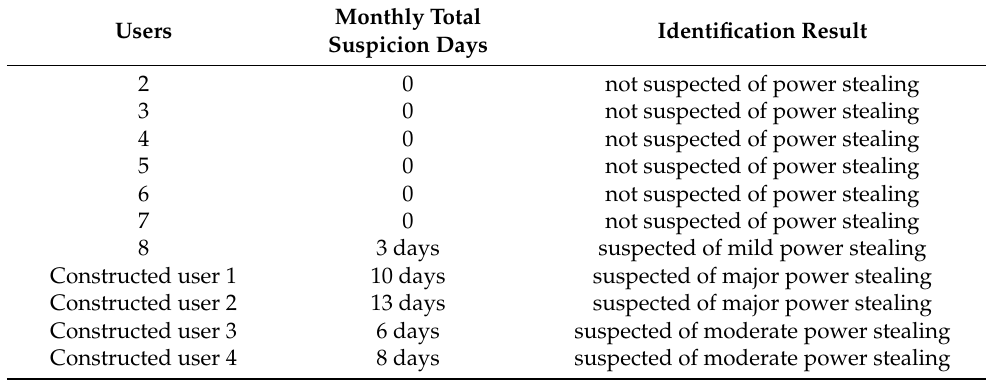
Table 5. Identification results of all